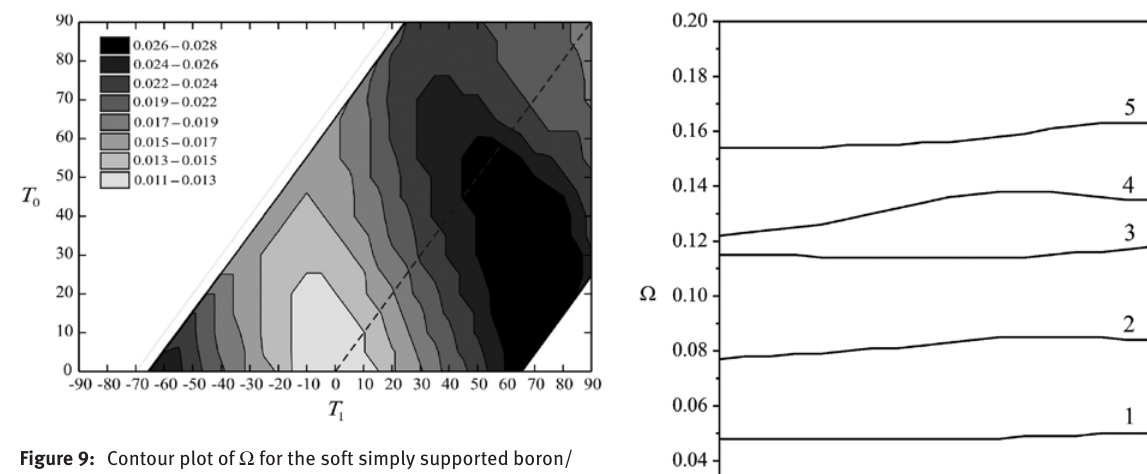
Figure 10: Frequency parameter Ω versus T